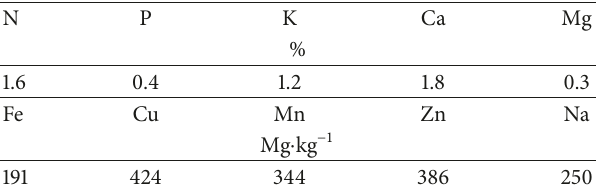
Table 4: Mineral content of mucilagefrom O. cochenillifera